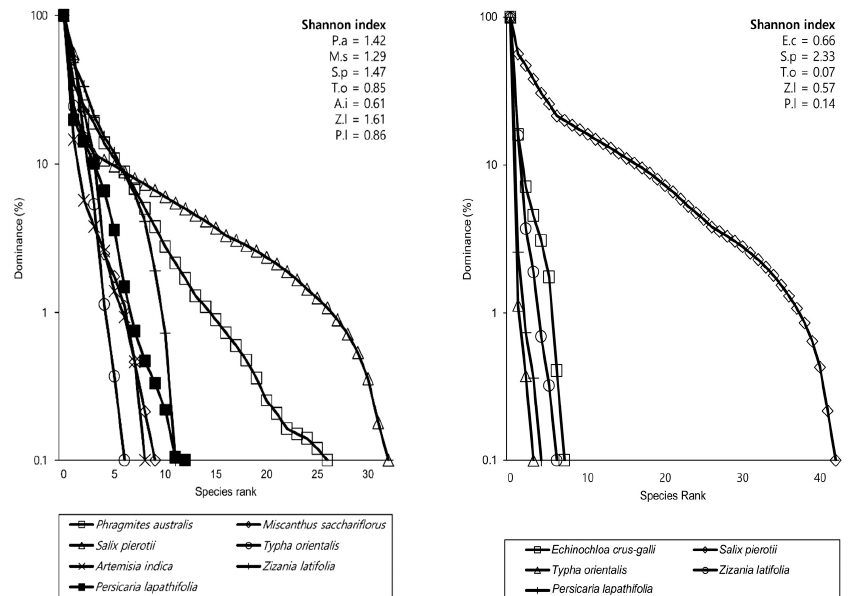
Figure 6. Rank-abundance curves and H’ of vegetation types established on stream bars ( left ) and riparian zones ( right ) of mountain gravel-bed river ( upper ), lowland river ( middle ), and estuary ( lower ) reaches.